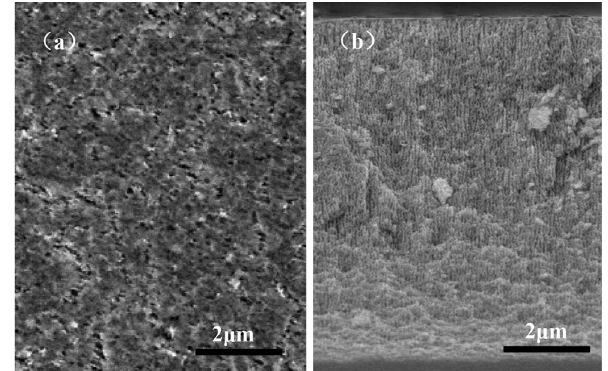
Figure 1. The etched InP prepared at 5 V for 2 min in 0.5 M HCl solution for ( a ) top-view SEM image and ( b ) cross-sectional SEM image.